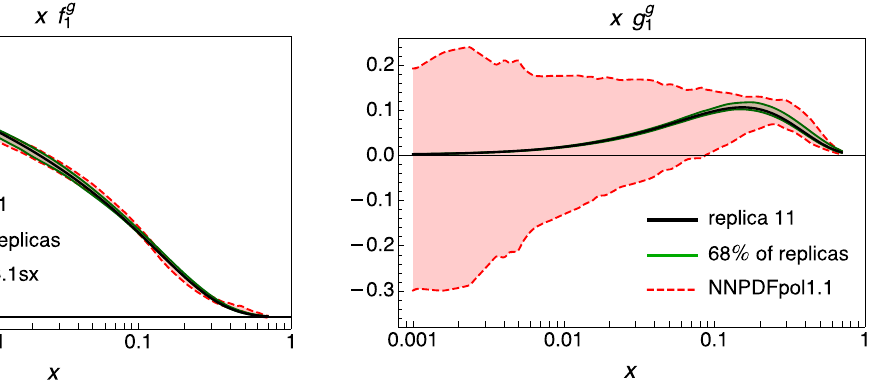
parametrization of xg g [79]. Green band for the 68% uncertainty band 1 of the spectator model fit. Solid black line for the result of the replica